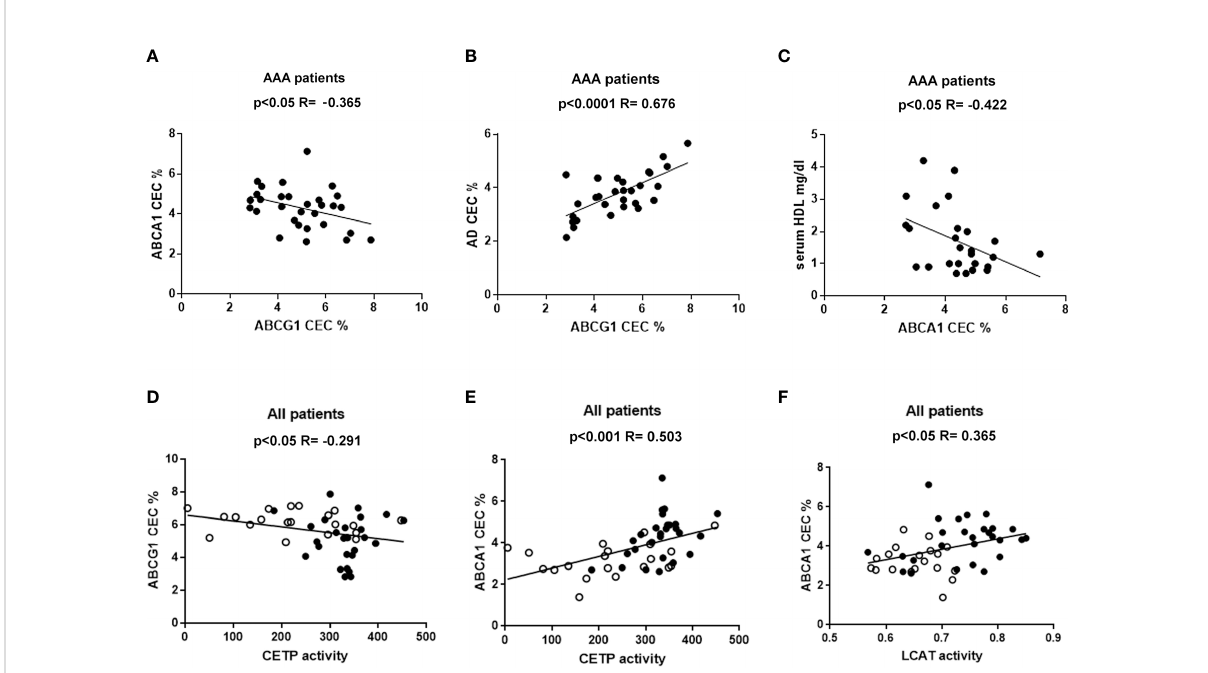
FIGURE 3 Correlations between HDL CEC and other parameters. Panel (A – C) refer to statistically signi fi cant correlations found only in AAA patients. Panels (D – F) show the statistically signi fi cant correlation found considering together non-AAA control ( ο ) and AAA patients ( ●